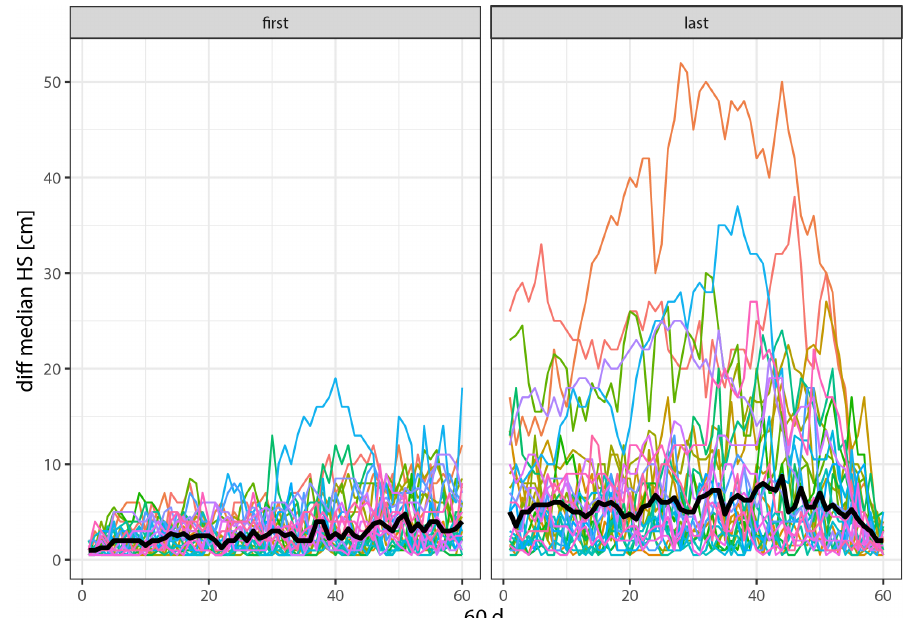
Figure 3. Median daily absolute differences in snow depth for each station pair for the first and last 60d of each snow season. The bold line highlights the median of all station